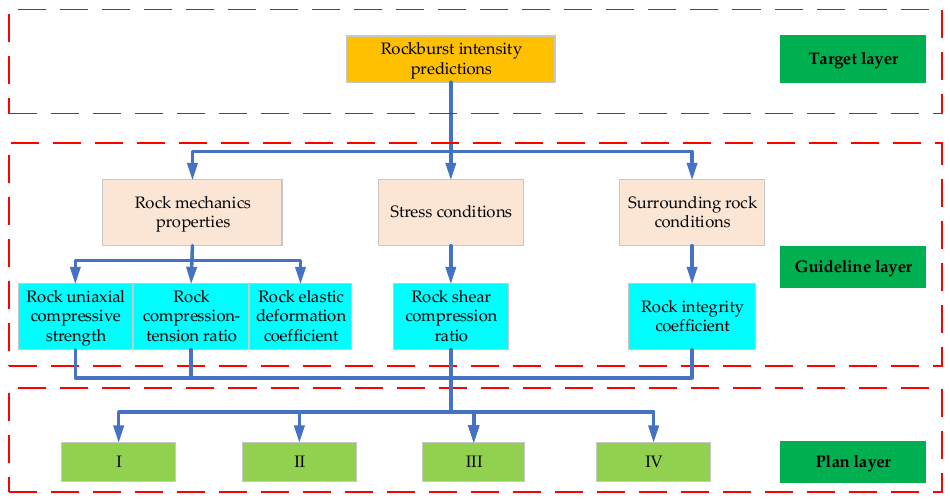
Figure 2. A diagram of the evaluation indicator hierarchy.